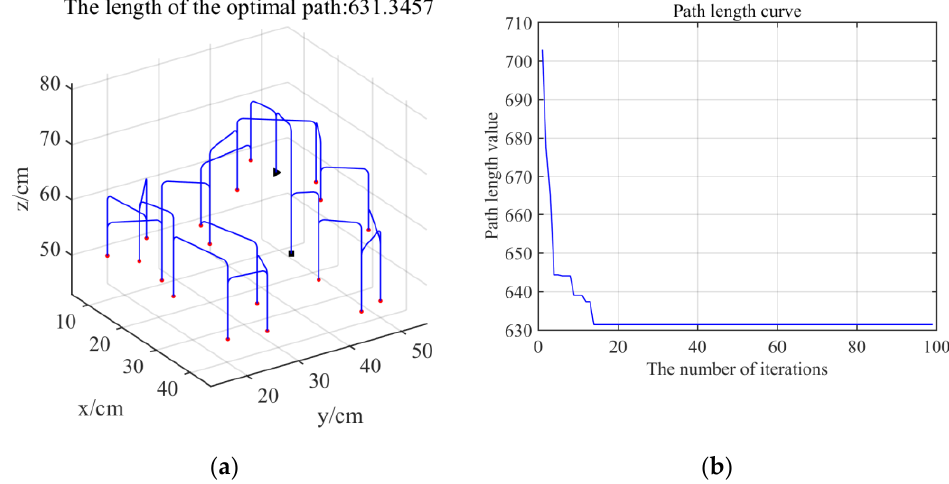
Figure 13. The fixed height ∩ -shaped track: ( a ) Simulation of picking path results; ( b ) Path length change curve.